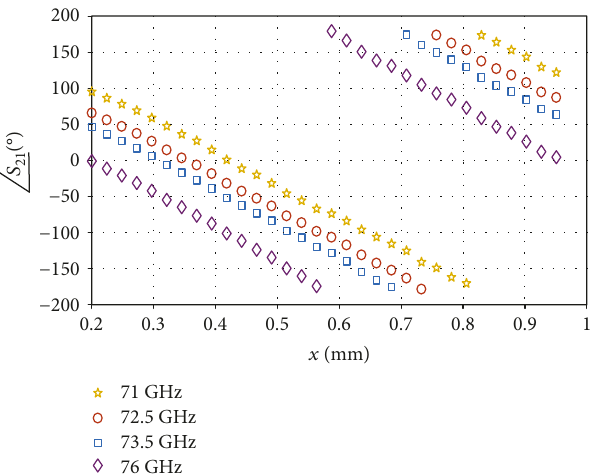
Figure 10: Simulated phase of the S function of x .